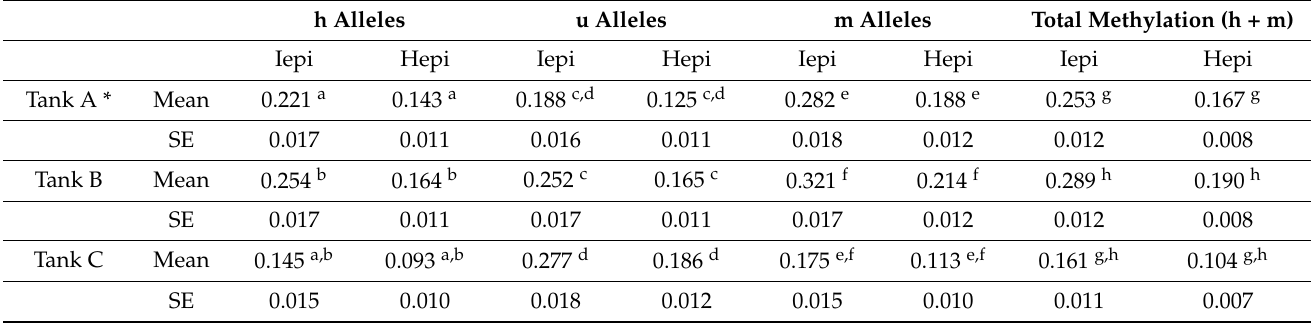
Table 2. Mean epigenetic Shannon Information Index (Iepi), epigenetic diversity (hepi) and standard error (SE) for the three tanks. A Kruskal–Wallis test provided very strong evidence for a differ- ence ( p < 0.001) between the mean ranks of at least one pair of groups for all comparisons for h, m, u, and total alleles. Dunn’s pairwise tests were carried out for these pairs of groups. Significant differences are provided based on Dunn’s post hoc tests with Bonferroni correction among treat- ments for each treatment and are indicated with the same letters. h alleles = hemimethylated, u alleles = unmethylated alleles, m alleles = methylated alleles. h Alleles u Alleles m Alleles Total Methylation (h +